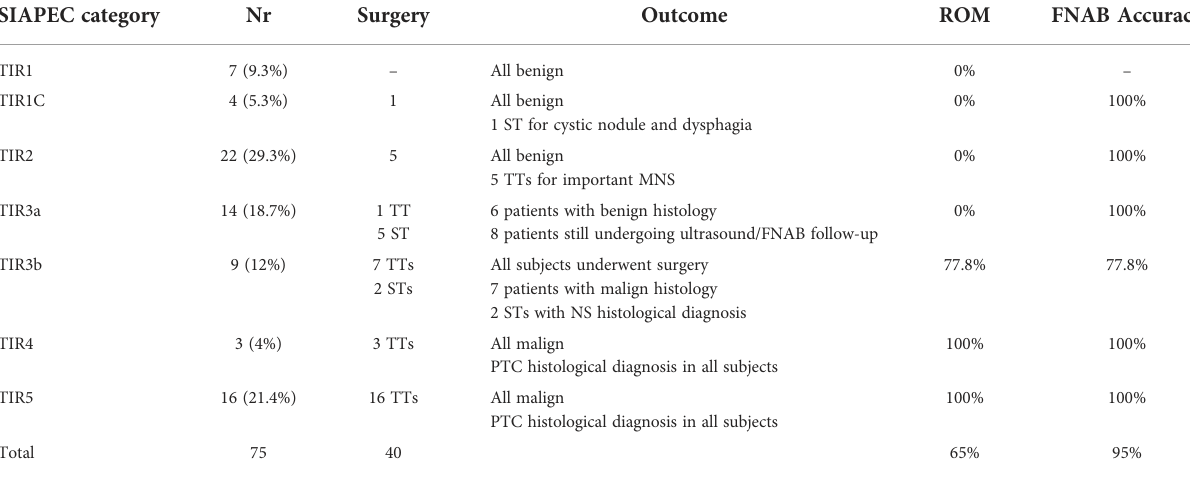
TABLE 2 Cytological, histological data, malignancy rate and FNAB accuracy for each cytological category. SIAPEC